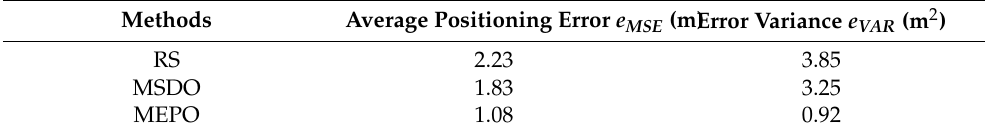
Table 4. Comparison of localization effects of different anchor nodes selection methods in path 2.